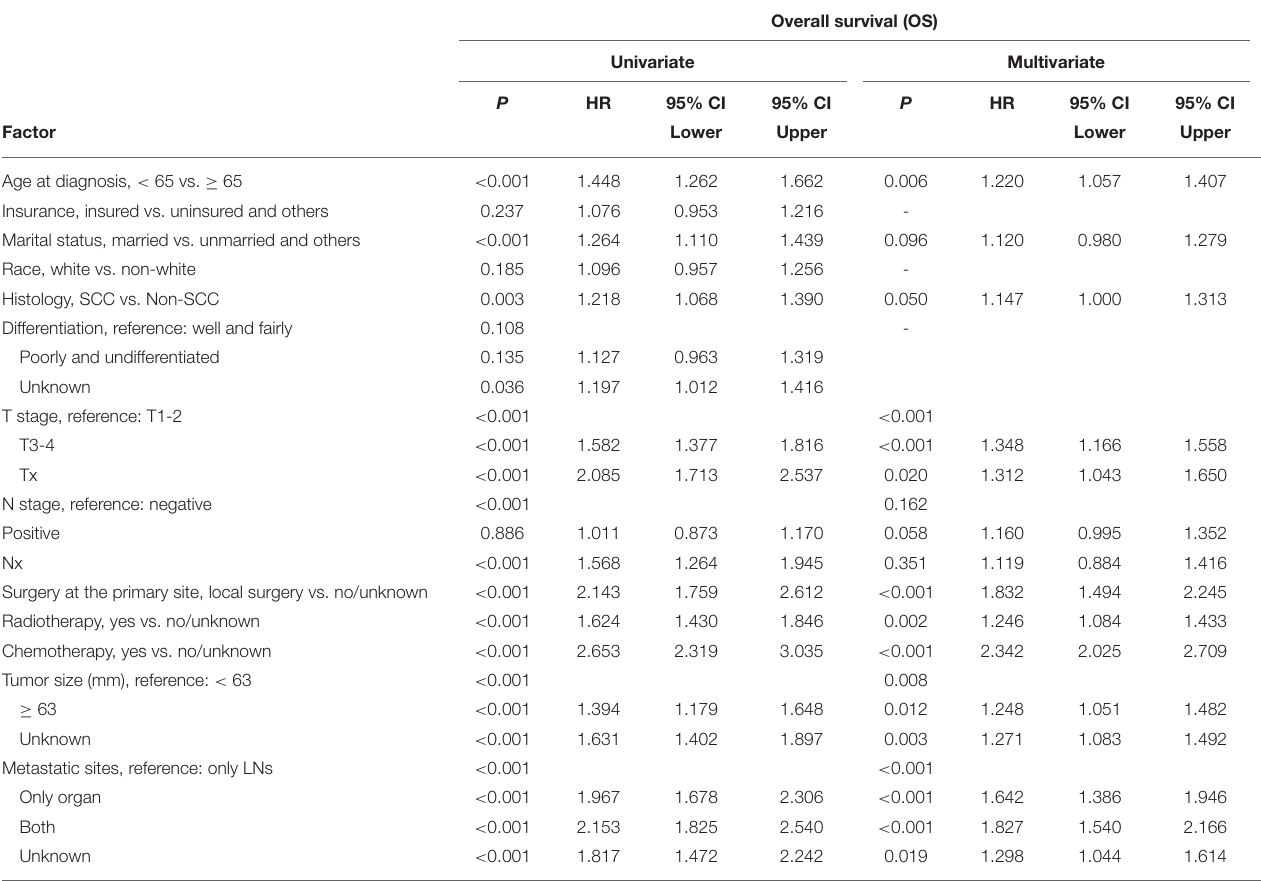
TABLE 2 | Univariate and multivariate analyses of OS in the training group.